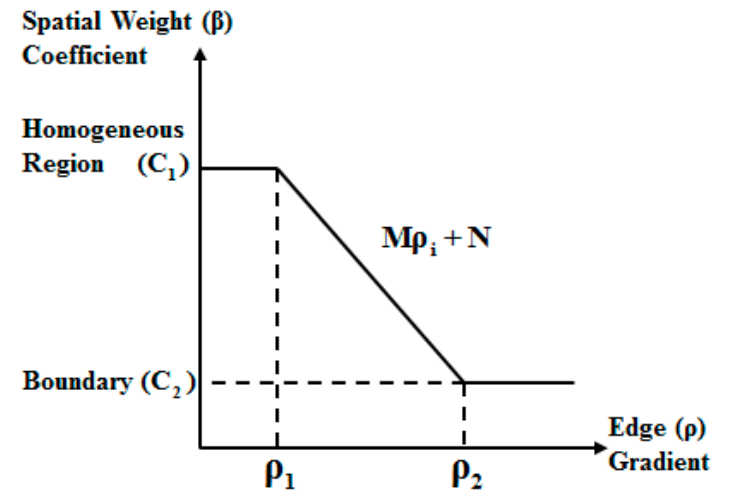
Figure 3. Relationship between the weighting coefficient and the combined edge gradient.